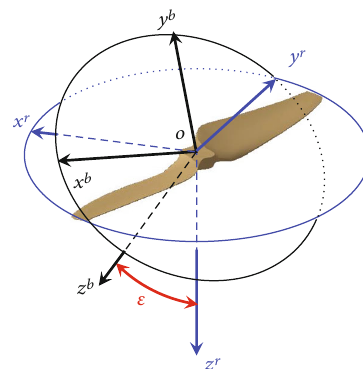
Figure 3: The oxyz axes of the rotor.